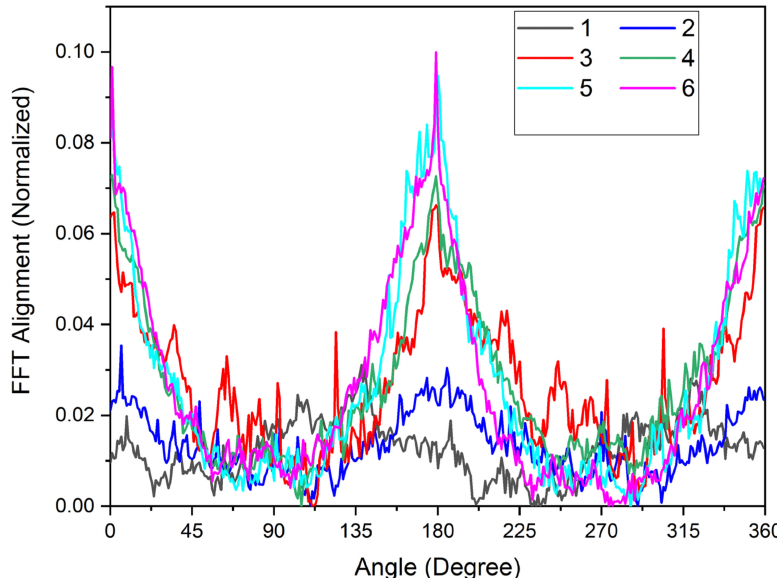
Figure 5. Alignment analysis and directional analysis: 1—0 rpm (flat plate collector); 2—500 rpm; 3—1000 rpm; 4—1500 rpm; 5—2000 rpm; 6—2500